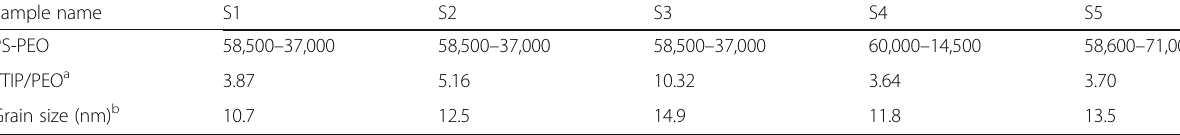
Table 1 Samples with various molecular weights of PS-b-PEO and its blending ratio with